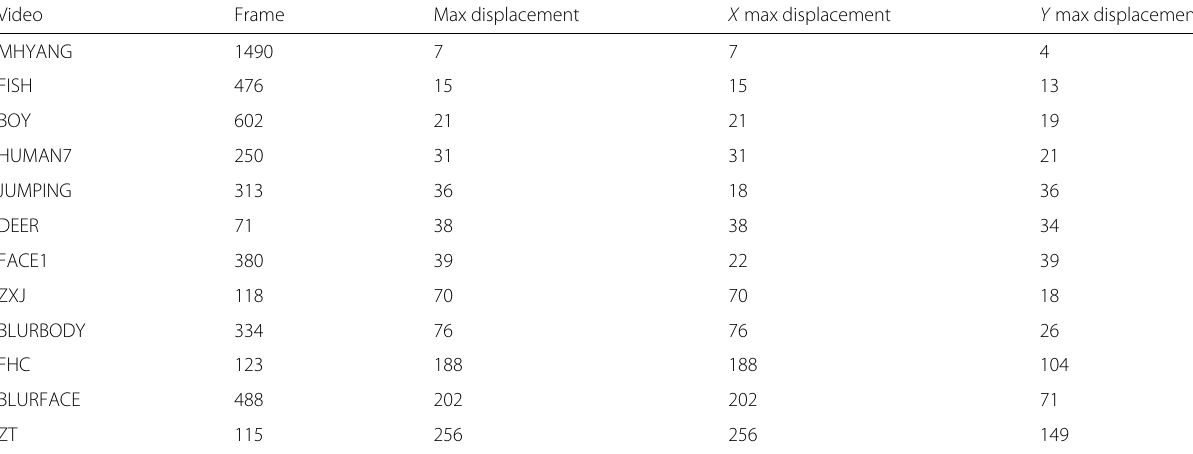
iteration number, and the Z -axis denotes the similarity